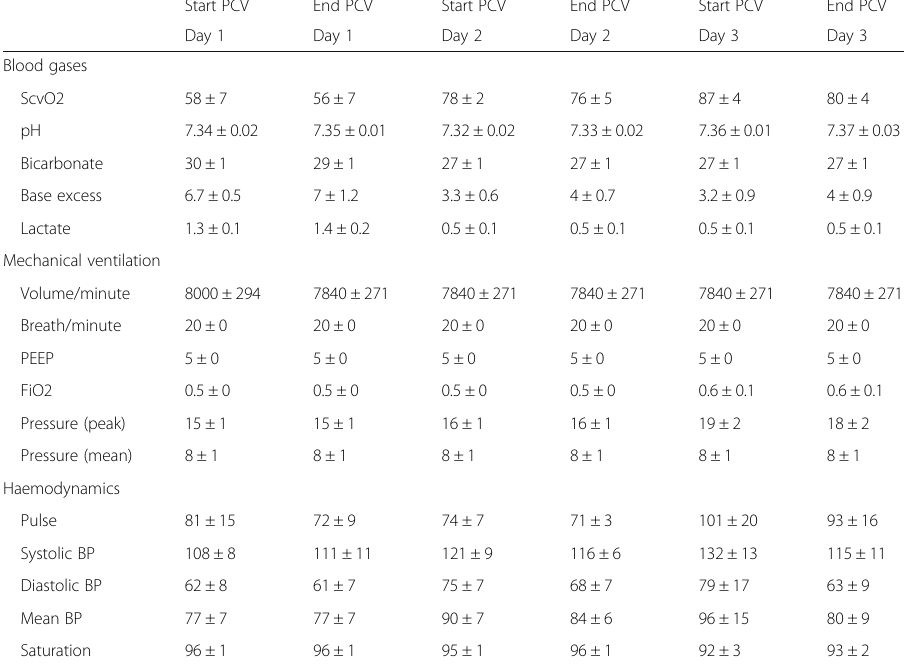
Table 2 Hemodynamics parameters at the start and at the end of the daily measurements during pressure-controlled ventilation